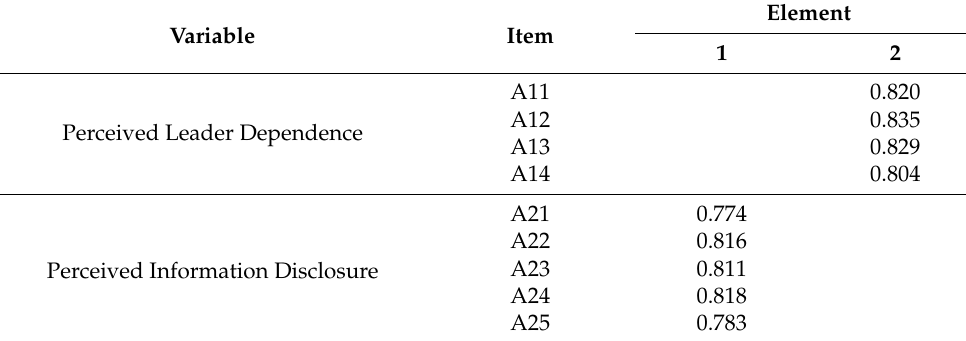
Table A2. Rotated Composition Matrix of Perceived Leader Trust.